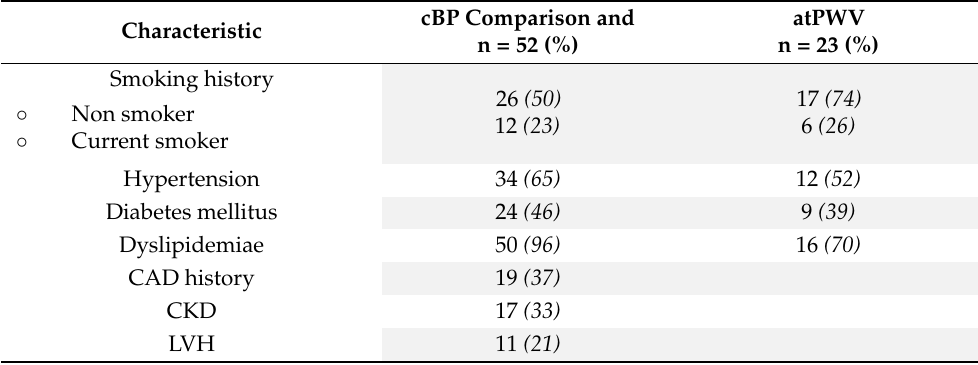
Table 1. Clinical characteristics of the patients included. CAD = coronary artery